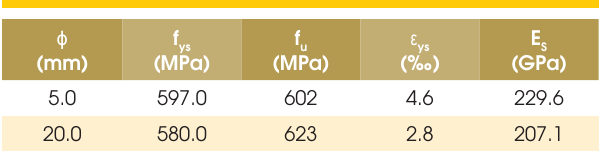
Table 5 – Properties of steel bars with diameter of 5.0 mm and 20.0